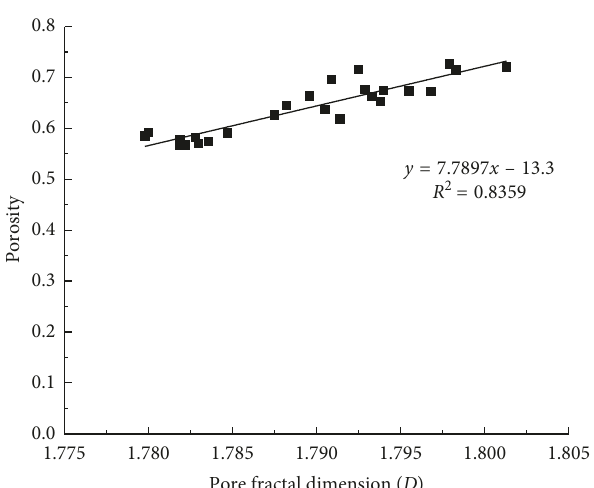
Figure 9: Relationship between pore fractal dimension and shape factor. Figure 8: Relationship between pore fractal dimension and